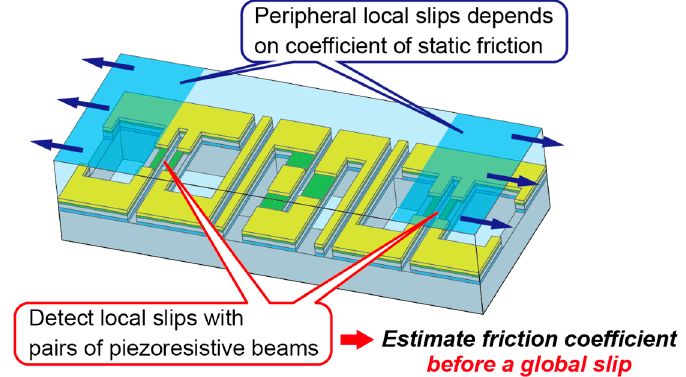
Figure 1. Conceptual sketch of the proposed sensor.